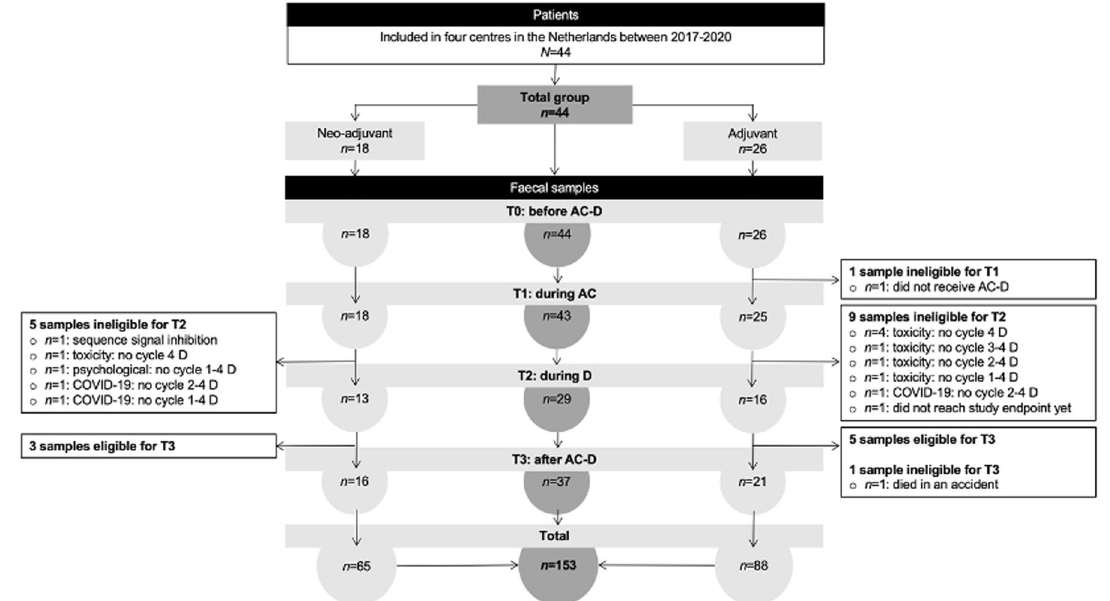
Fig. 1 Flow chart. The fl ow chart presents the number of patients included and the number of faecal samples collected by those patients during the study period. Multiple patients who did not collect a faecal sample at T2 were able to collect a faecal sample at T3. In total, 44 patients collected 153 faecal samples at four-time points. 28 participants provided all four samples. The total group is presented in the middle. On the left and right sides, the total group is subdivided into neoadjuvant and adjuvant